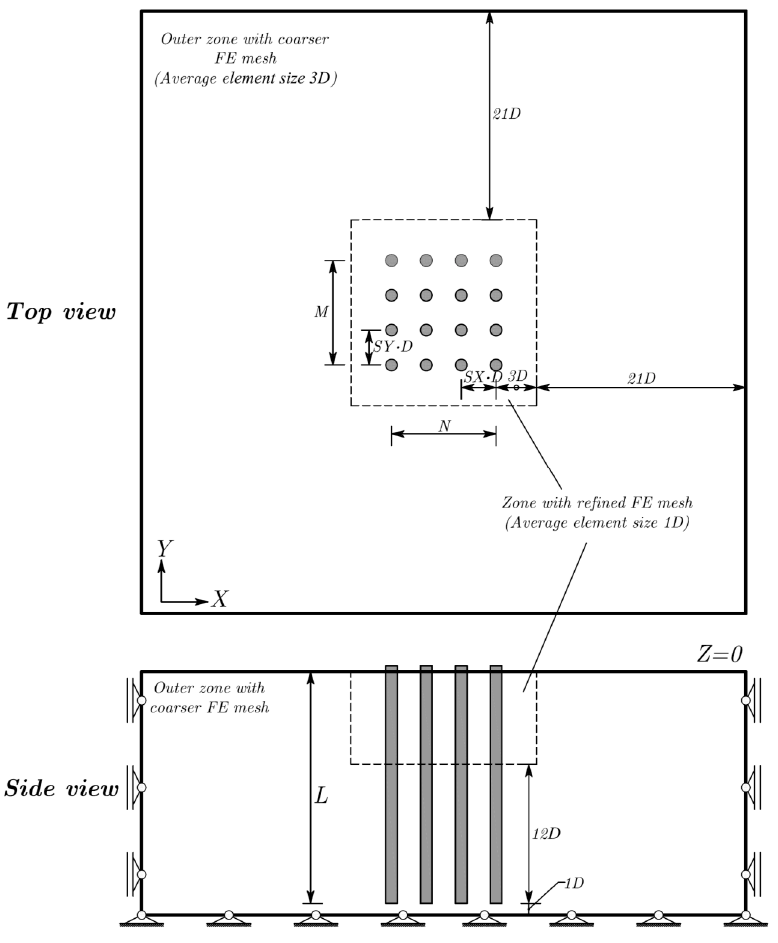
Figure 4. Sketch of the numerical model with parameterized geometry. N , M denote the number of piles in X and Y direction, respectively. SX and SY are center-to-center pile spacings, in diameters D .